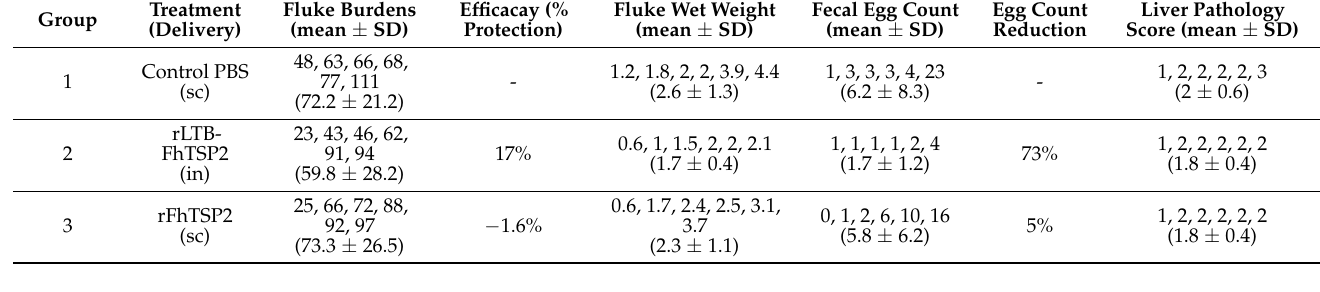
Table 1. Final fluke infection parameters for the control and vaccination groups. Recovered fluke burdens, fluke wet weights, fecal egg counts, and host liver pathology values for animals within Group 1 (subcutaneous PBS vaccination), Group 2 (intranasal rLTB ‐ FhTSP2 vaccination), and Group 3 (subcutaneous rFhTSP2 vaccination).